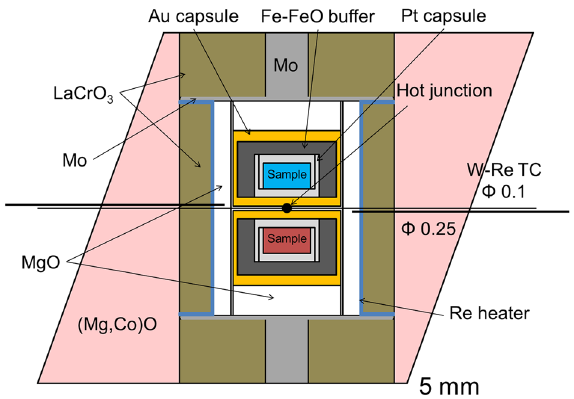
Figure 7. Schematic illustrating the cell assembly that was used in high-pressure and high-temperature experiments using multi-anvil apparatus. A LaCrO 3 (brown) sleeve served as a thermal insulator. A platinum (light gray) sample capsule was made by combining two platinum tubes with 0.1 mm wall thickness, and outer diameters of 1.3 mm and 1.5 mm, respectively, by welding each end of the capsules. A gold capsule (yellow) was made from a gold tube with 0.1 mm wall thickness and 2.5 mm outer